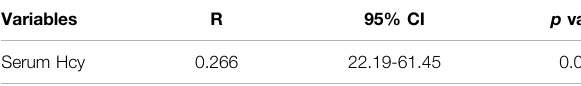
TABLE 7 | Logistic regression analysis of restenosis severity.